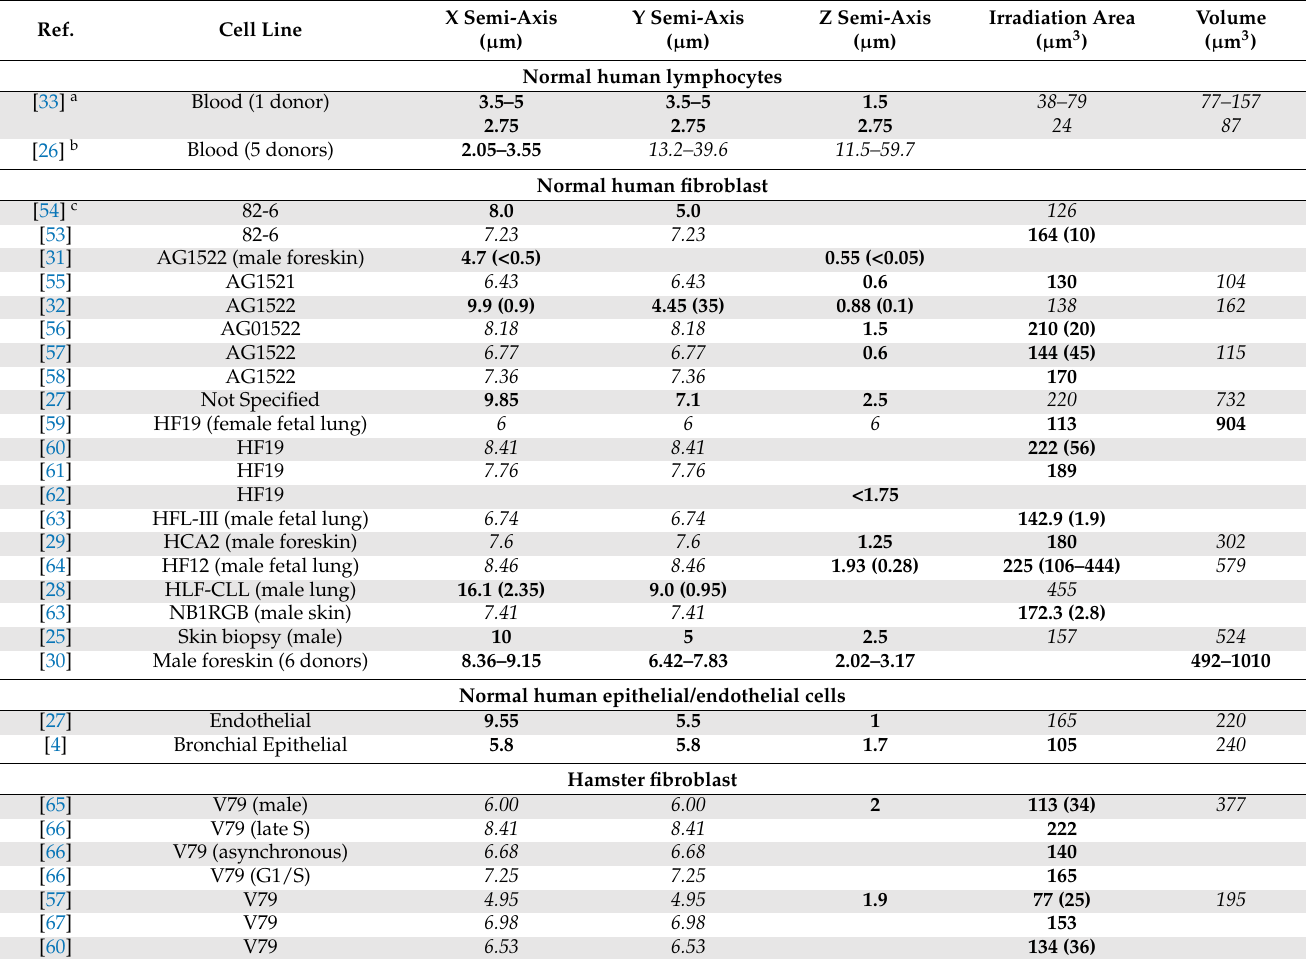
Table 3. List of experimental nuclear sizes referenced in the literature. Experimental measurements are in bold with standard deviation values in parenthesis when available. Calculated values are in italic as an indication and assuming that the nucleus has a spherical/ellipsoidal